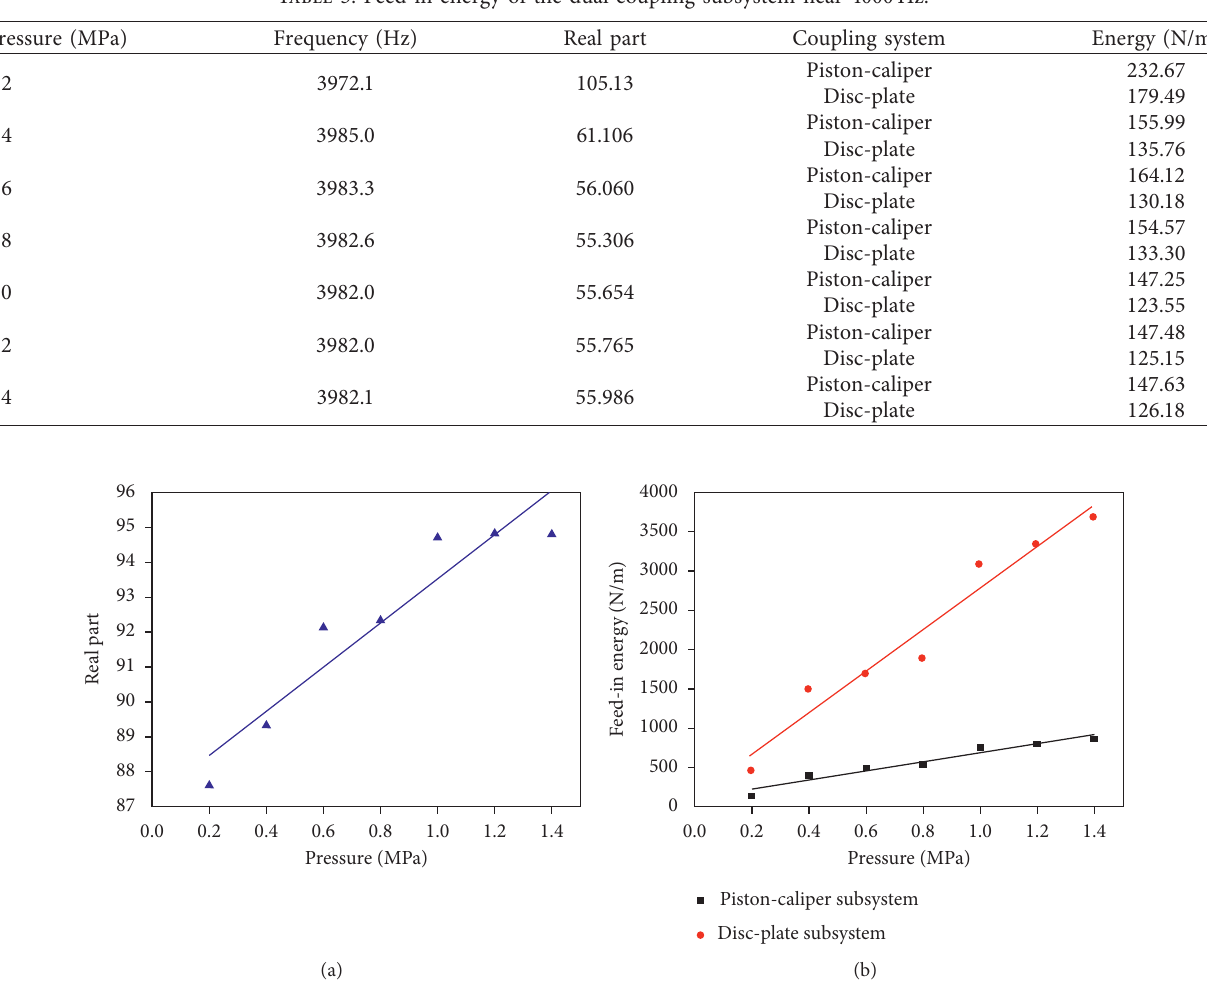
Figure 7: Relationships between brake oil pressure, real part, and feed-in energy at 3000Hz. (a) Linear relationship between brake oil pressure and the real part. (b) Linear relationship between brake oil pressure and feed-in